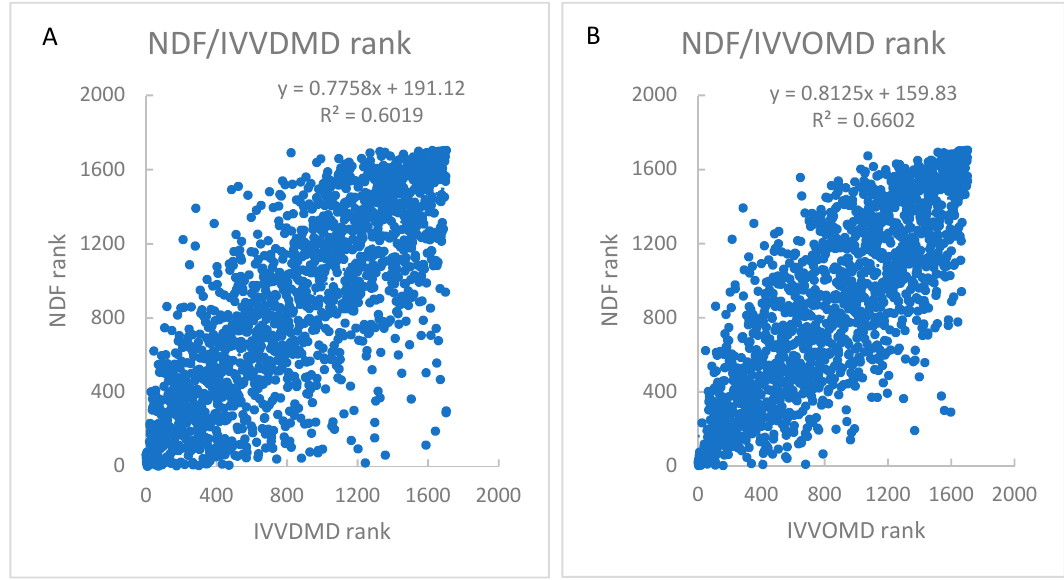
Figure 5. ( A ) The rankings for parameters IVVDMD and NDF showed R 2 of 0.602 for correlation between rankings of 1610 plants. ( B ) NDF and IVVOMD rankings showed R 2 of 0.660 for the correlation between rankings of 1610 plants.